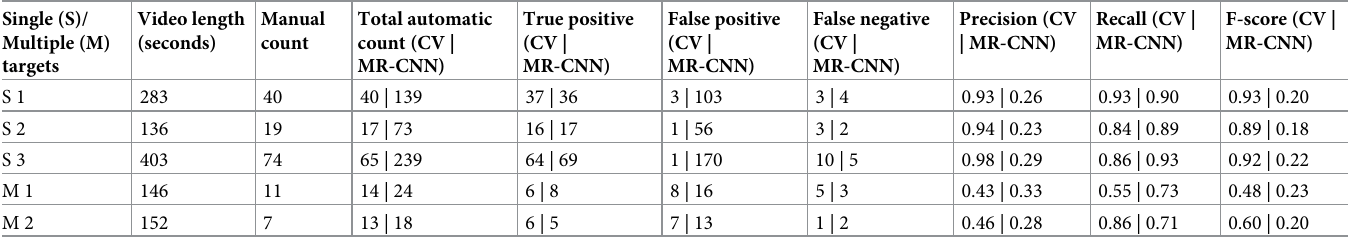
Table 4. Results of the automated detection and count of N . norvegicus .